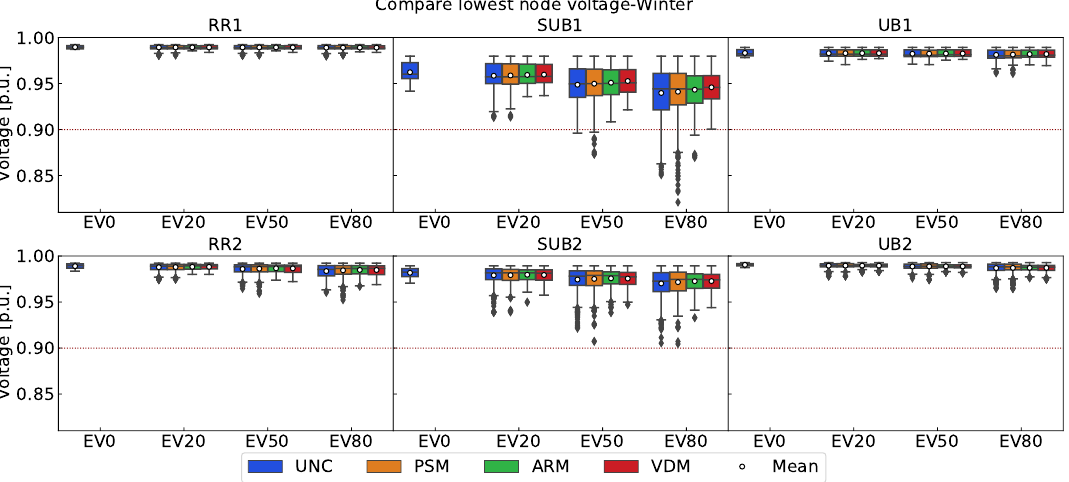
Figure 8. Comparison of per time step minimal node voltage distribution for one winter week.